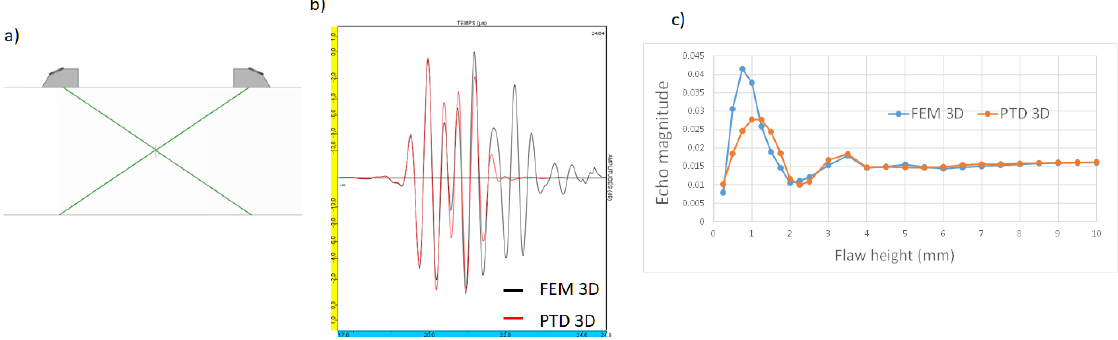
Figure 4. ( a ) Inspection of a 25 mm extent rectangular crack of varying height using P60 waves in TOFD mode at 2.25 MHz. ( b ) Superimposition of Ascans simulated both by the 3D FEM and PTD for the echoes generated for the 5 mm high crack. ( c ) Echo magnitude versus the flaw height.